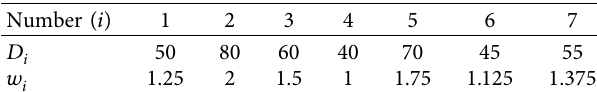
Figure 7: S/N ratio plots for the modified NSGA-II. Table 2: The data of the small-scale instance.